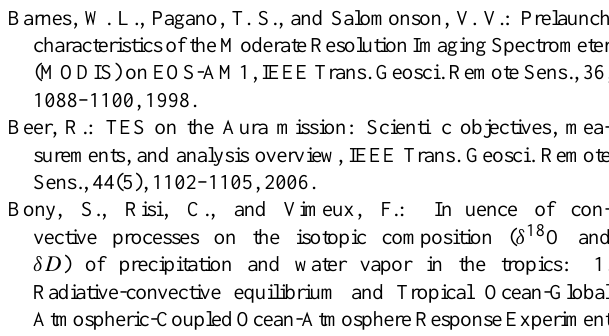
Fig. A1. An example of simulated retrievals of HDO/H 2 O profiles for the different cloud conditions. 5% depleted HDO/H 2 O profile was assumed as the true state vector ( x ) in this calculation. 8